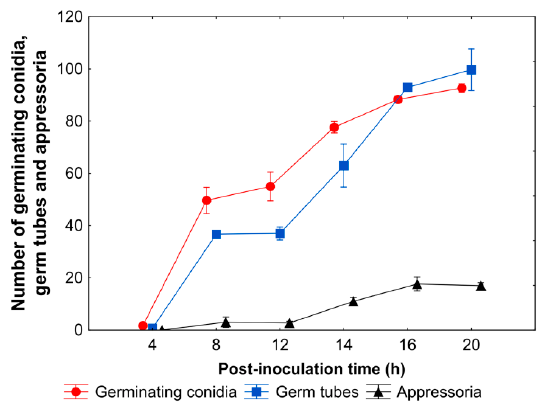
Figure 2. Quantitative data of A. brassicicola development on B. oleracea leaves. The values are means ± SE of 3 replicates. ± SE of 3 replicates.